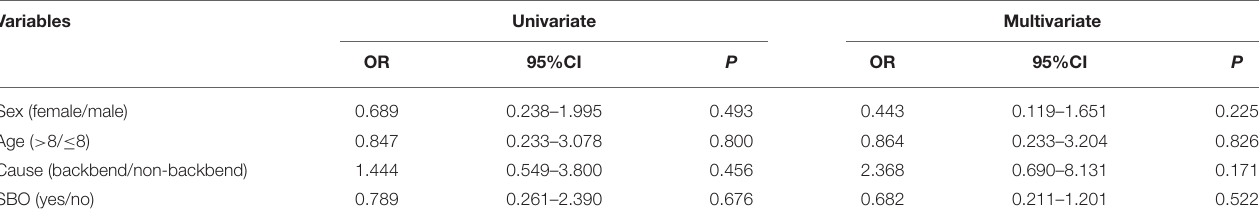
TABLE 3 | Univariate and multivariate logistic regression analysis of the severity of the injury. Variables Univariate Multivariate OR 95%CI P OR 95%CI